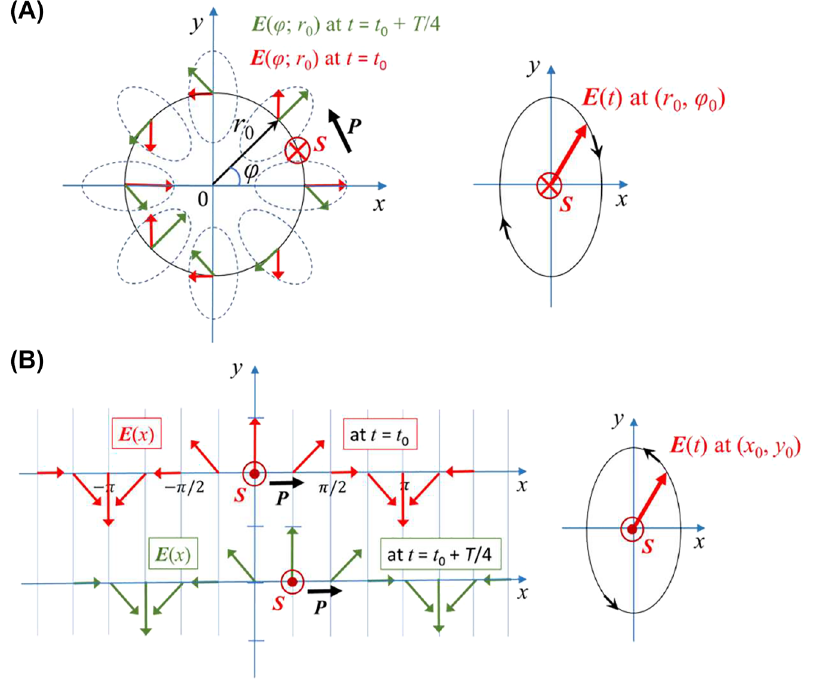
Figure 2: Spatial distribution and time evolution of electric fields with transverse spins. (A) Circularly polarized dipole field for 𝜃 = 90 ◦ . The spatial distribution of E -vector orientation at a given time point (left panel). The green arrows denote E -vector orientation and the red arrows are after a T /4-time lapse, where T is the period of oscillation. E -vector rotates counter-clockwise advancing its phase to the + 𝜑 -direction. E -vector at a given location elliptically rotates along the clockwise orientation (right panel). Spin vectors orient to the transverse direction (the − z -direction) and Poynting vectors to the azimuthal direction (the + 𝜑 -direction). (B) Surface plasmon field on a planar metal surface. At a given time point, E -vector rotates clockwise advancing its phase to the − 𝜑 -direction (left panel). E -vector at a given location rotates counter-clockwise (right panel). Spin vectors orient to the transverse direction (the + z -direction) and Poynting vectors to the propagation direction (the + x -direction).